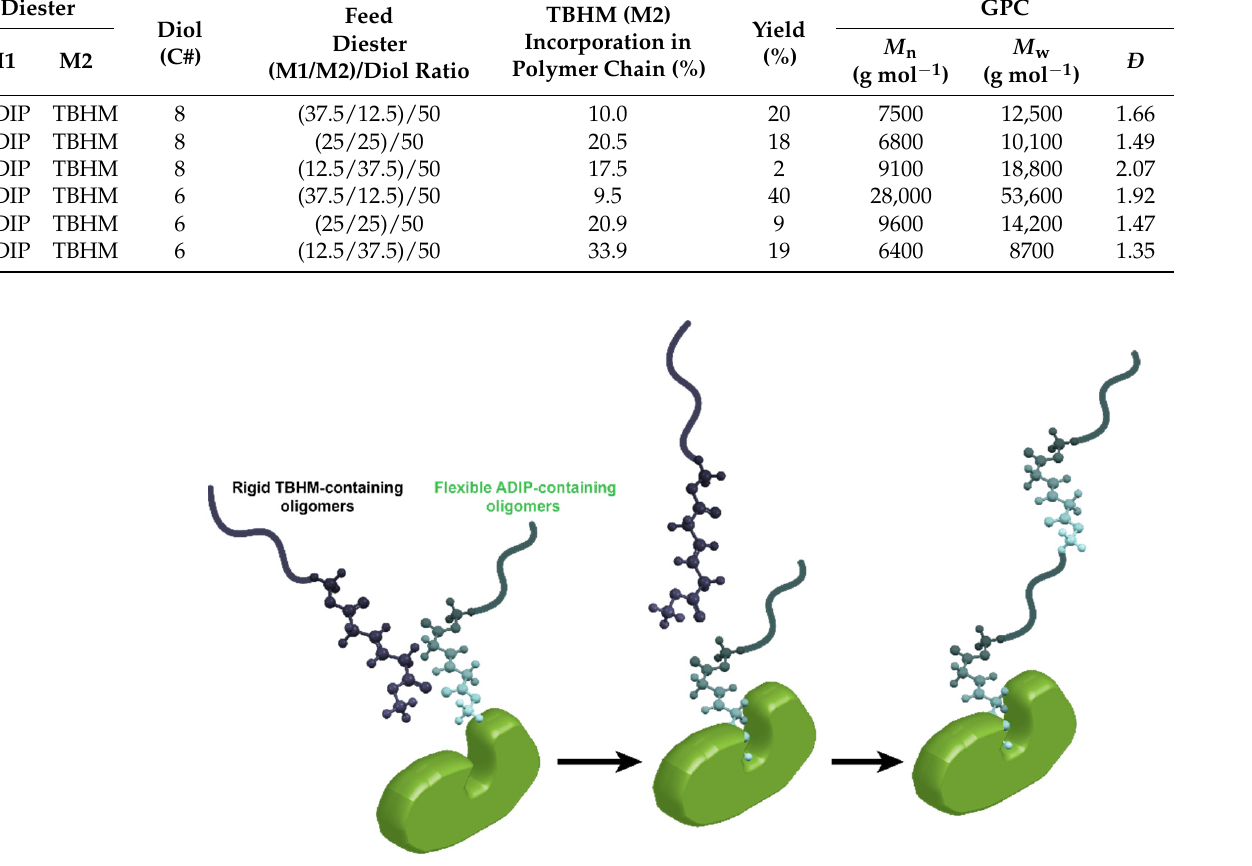
Figure 3. Proposed competitive propagation reaction between flexible saturated ADIP and rigid unsaturated TBHM in mixed monomer feed system. The saturated ADIP-containing oligomers are more preferable for the enzyme active site due to their flexibility.